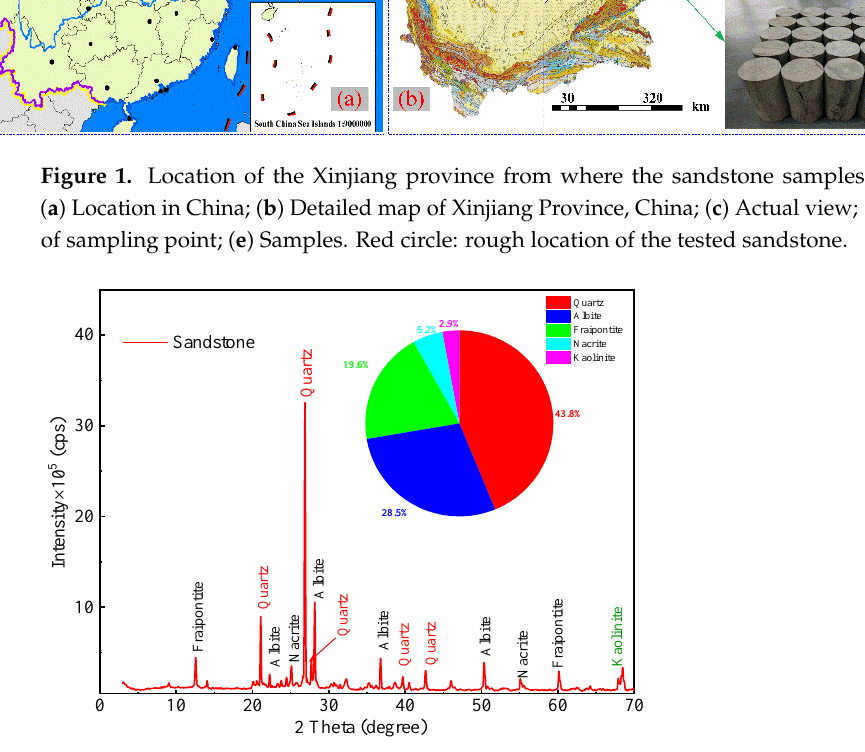
Figure 2. X-ray diffraction results for the tested sandstone.